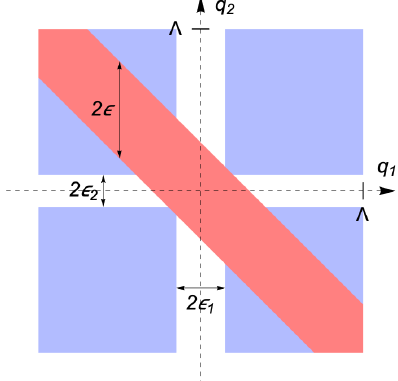
Figure 1 . Integration region for the right-hand side of (A.15). For the integral over the blue region we change variables from ( q 1 , q 2 ) to ( q, q 2 ) where q = q 1 + q 2 . The limits of integration on q 2 then become a function of q, Λ , (cid:15) 1 , 2 . For example, when (cid:15) < q < Λ − (cid:15) 1 , the integral over q 2 covers [ q − Λ , − (cid:15) 2 ] ∪ [ (cid:15) 2 , q − (cid:15) 1 ] ∪ [ q + (cid:15) 1 , Λ] . The test function does not depend on q 2 and can be pulled out of the q 2 integral. For all cases (cid:15) < | q | < 2Λ , the result of the q 2 integration, after taking the limits (cid:15) 2 → 0 followed by (cid:15) 1 → 0 , is captured by the second term on the right-hand side of (A.16). For the integral over the pink region we instead expand the test function around q = 0 and compute leading term in the resulting integrand. That computation requires first integrating over q 2 for fixed q 1 (where the limits of integration depend on q 1 , (cid:15), (cid:15) 2 ), then taking the (cid:15) 2 → 0 limit, then integrating over q 1 , and finally taking (cid:15) → 0